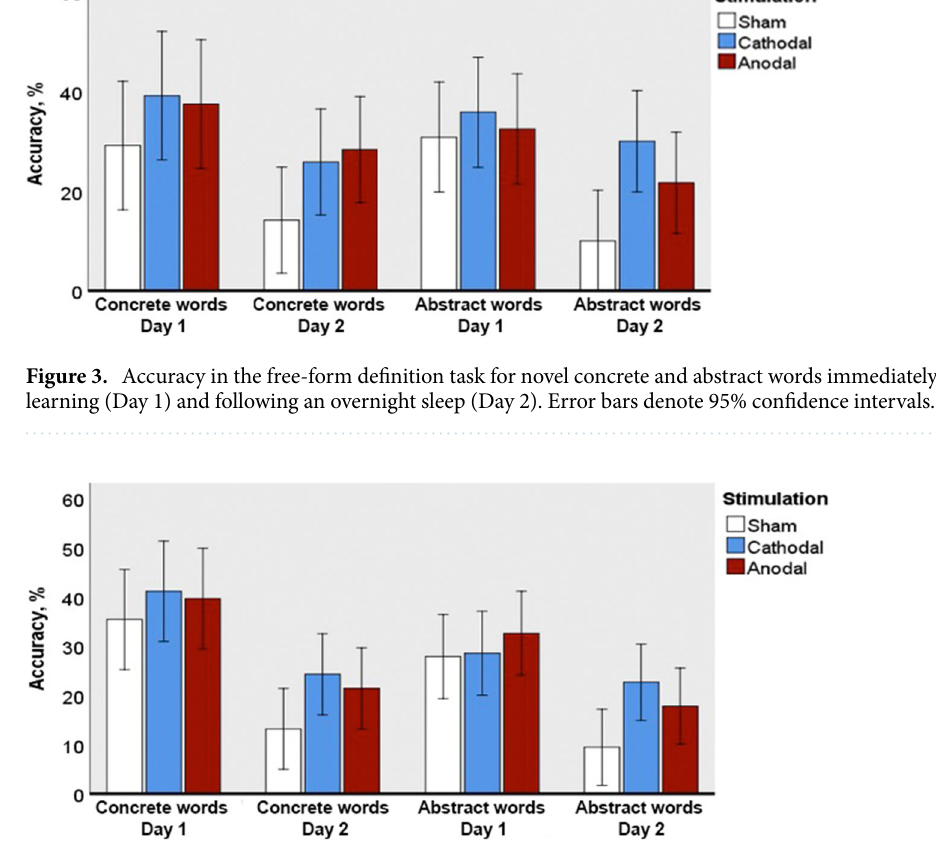
Figure 4. Definition quality ratings (%) in the free-form definition task for novel concrete and abstract words immediately after learning (Day 1) and following an overnight sleep (Day 2). Error bars denote 95% confidence